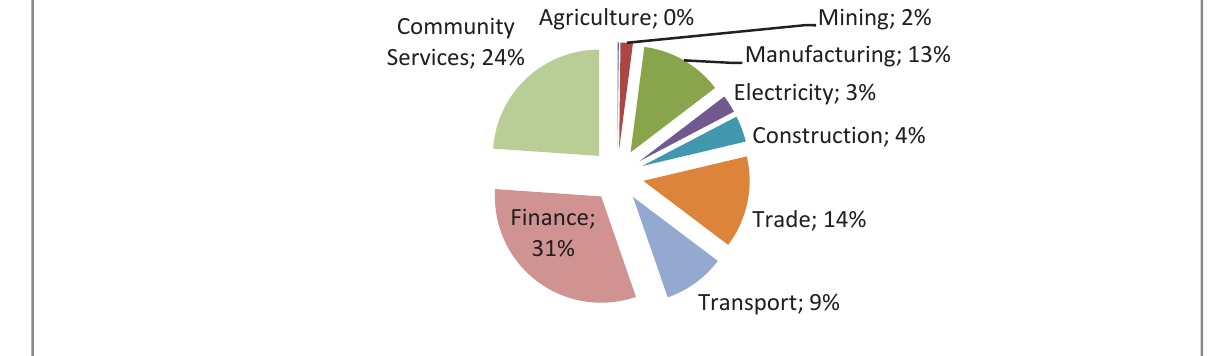
Fig. 5. Gross value added composition of the COJ 2014